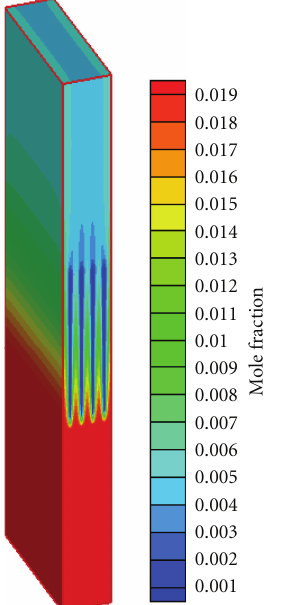
Figure 8: Hydrogen mole fraction contour for simulation per- formed for Gx-test series